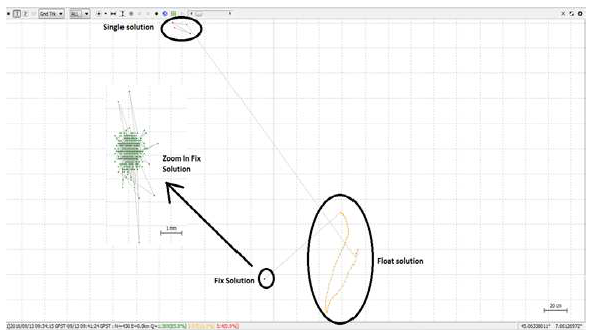
Figure 7. Real time position with fix, float and single solution The range laser scanner is connected to the RPi system through USB 2.0 interface. One scan returns 1080 distance values